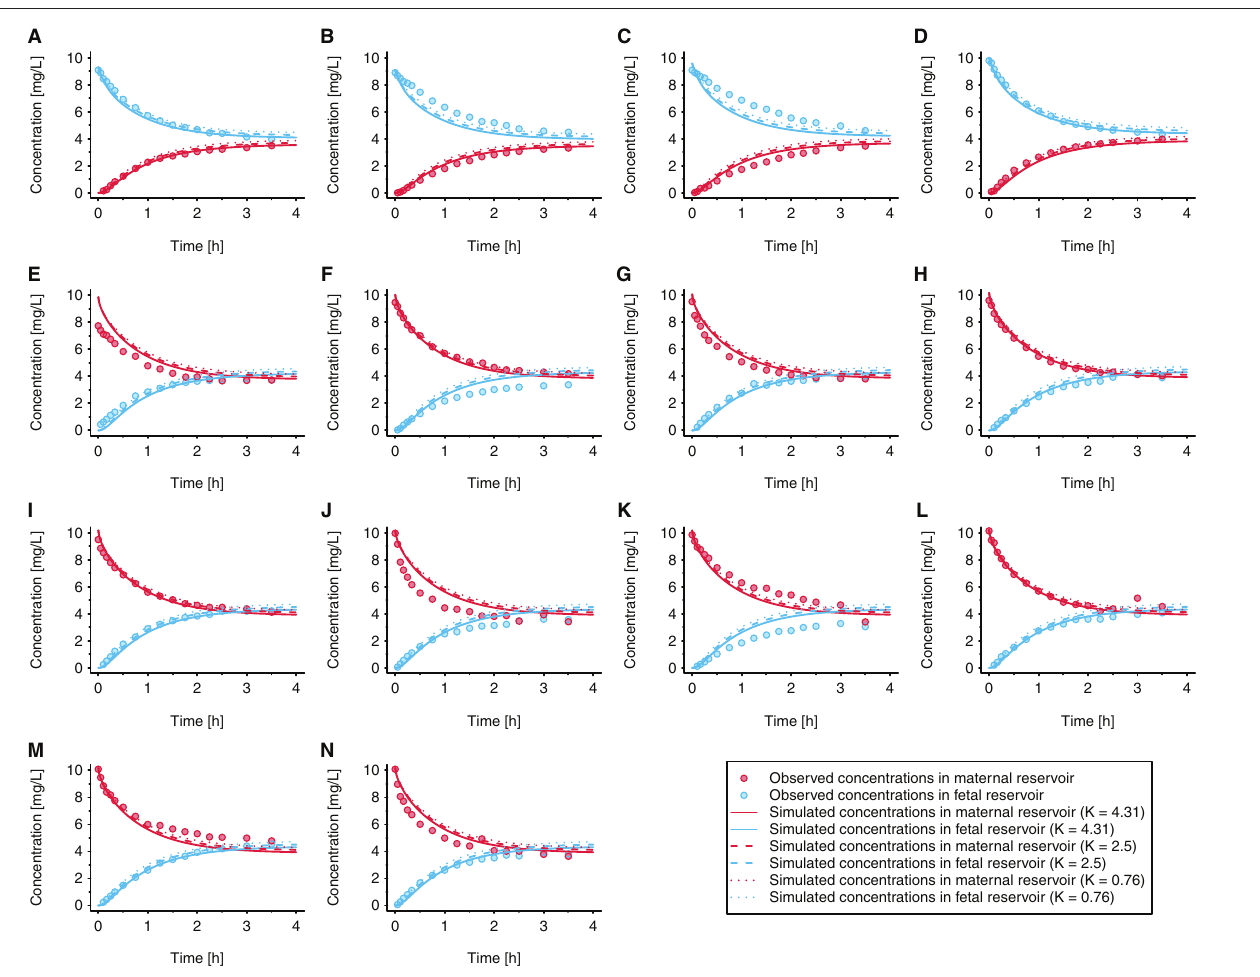
FIGURE 5 | Local sensitivity analysis for the placental partition coefficients ( K FM _ cell : perf and K F _ cell : perf ). In each experiment, acetaminophen was either administered to the fetal reservoir (A–D) or maternal reservoir (E–N) at time = 0h. The initial concentration was 10 mg/L in all experiments (to reflect clinically relevant concentrations); each panel refers to an individual experiment. All experiments were conducted under similar conditions. Observed data were taken from Conings et al. (